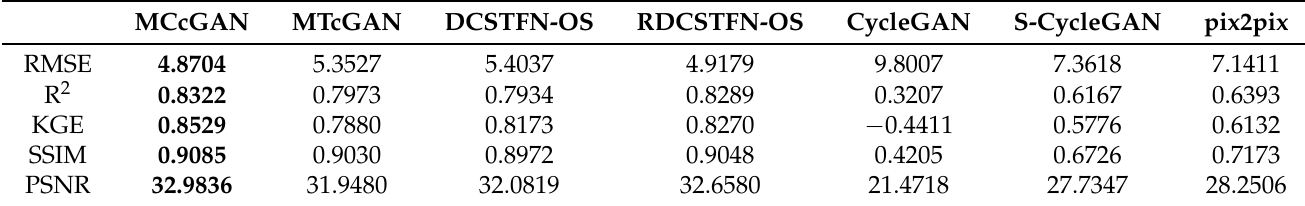
Table 4. The evaluation metrics of different methods for the green band in Area A at Time II (the bold result is the best among the different metrics).